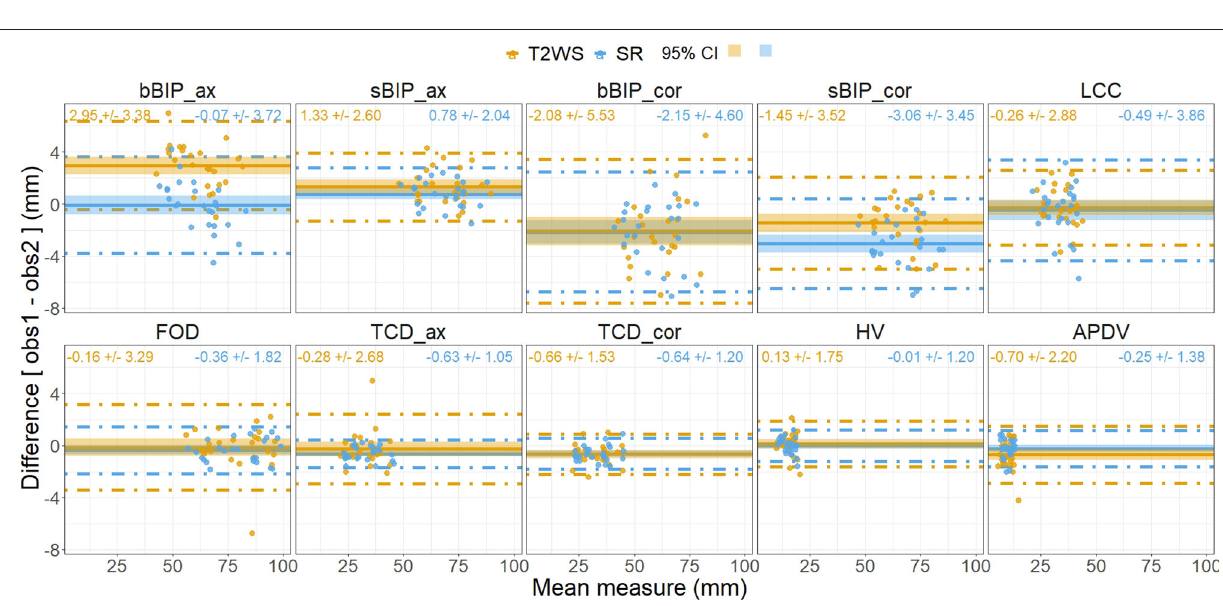
native T2WSs, which are frequently affected by motion.